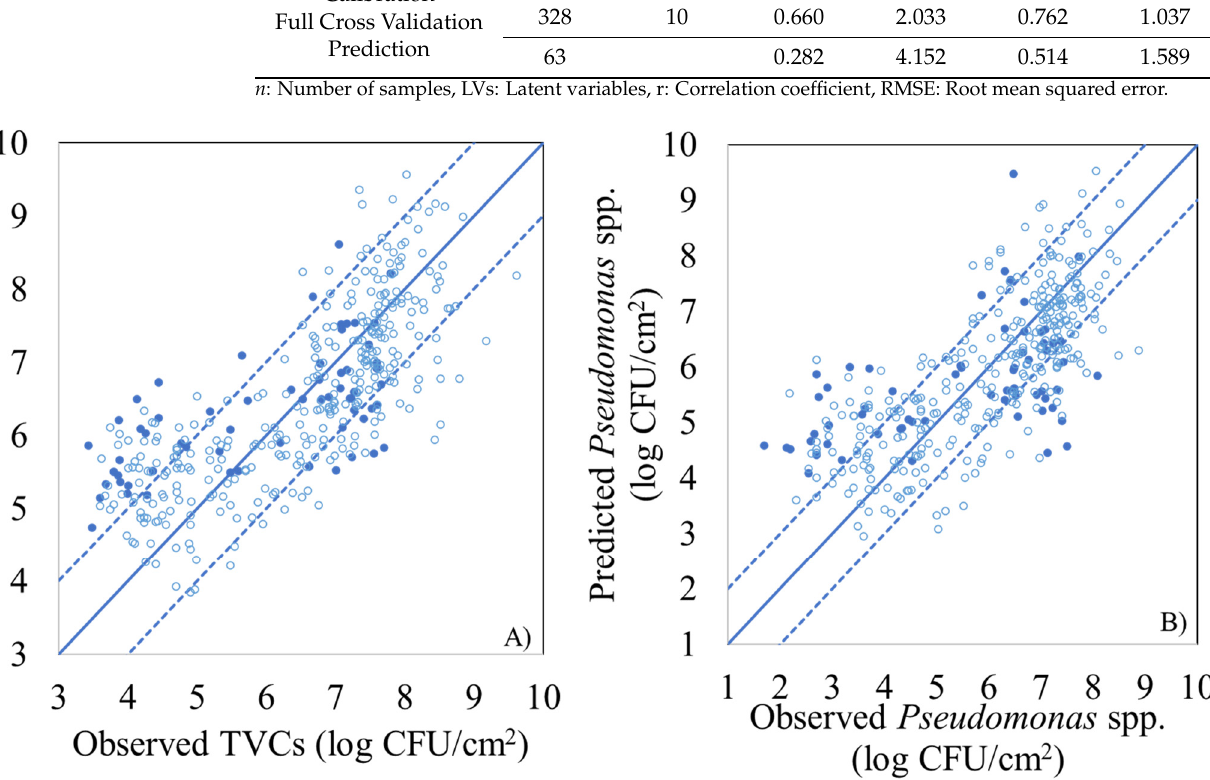
Figure 7. Typical FT-IR spectra in the range of 1000–2000 cm − 1 collected from chicken thigh fillet stored at 0 °C for 0 h (fresh = blue line) and after 366 h (spoiled = orange line).